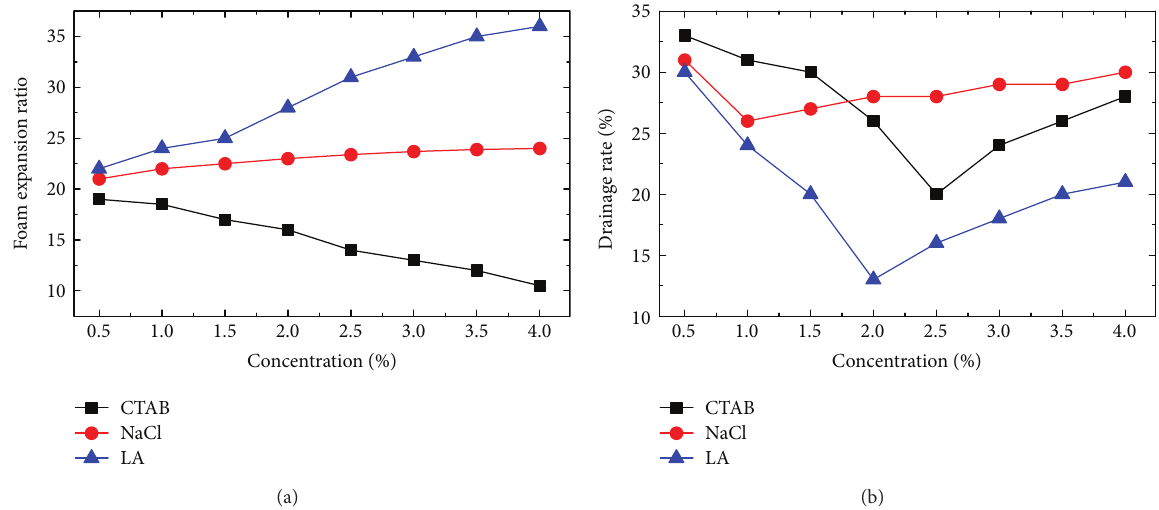
Figure 6: Modifying effects of foam stabilizer on drainage rate and foam expansion